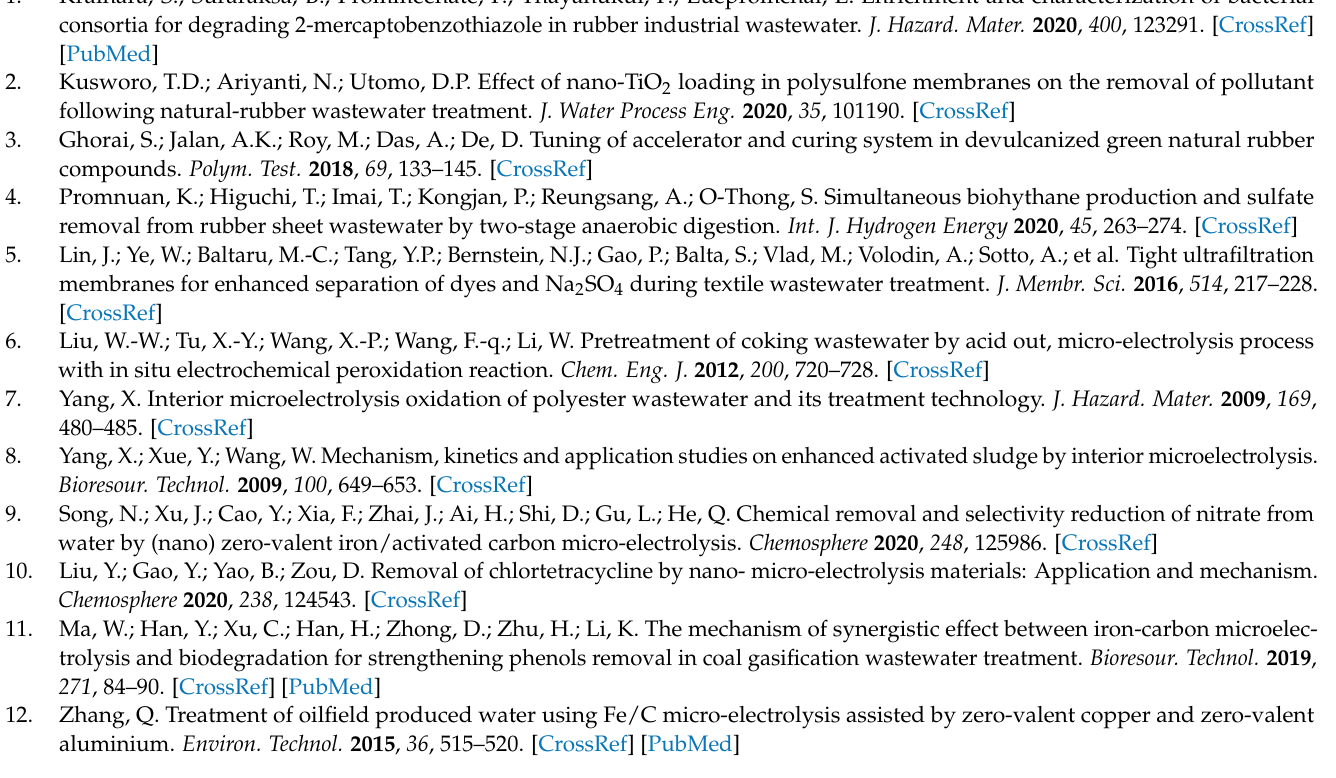
Table S2: Al/AC ME optimization validation